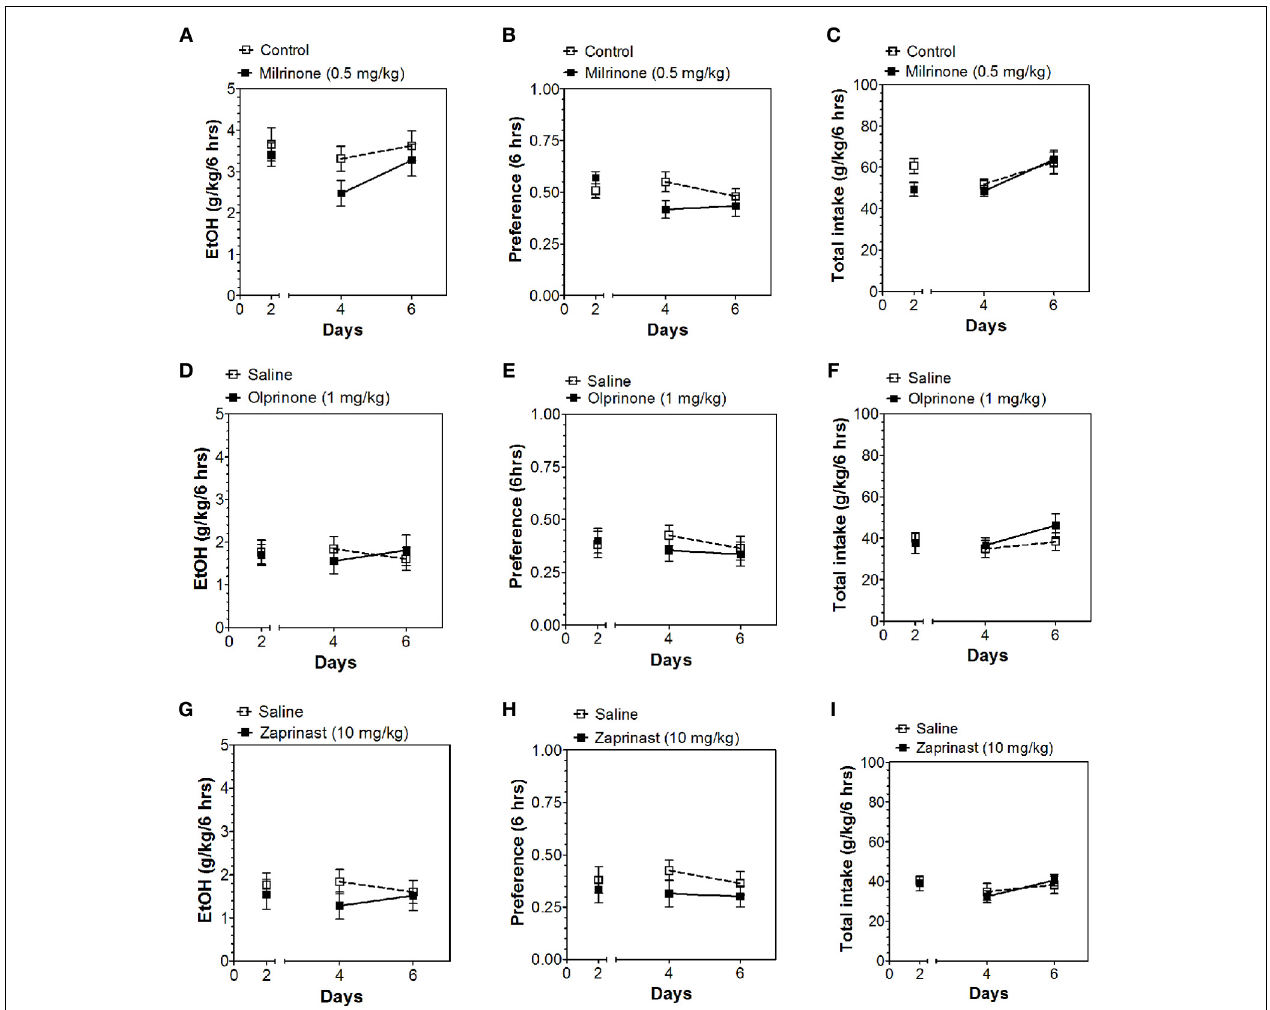
FIGURE 3 | PDE3 and PDE5 inhibitors do not alter alcohol intake during the first 6h of the 24-h two-bottle choice paradigm. Ethanol consumption is presented as g/kg/6h: (A) Milrinone (D) Olprinone (G) Zaprinast. Preference for ethanol: (B) Milrinone (E) Olprinone (H)